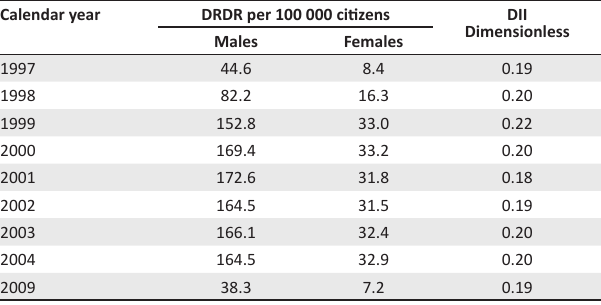
FIGURE 3: The unemployment inequality index (UEI) vs. the Human Development Index TABLE 6: Values of DRDRs and DII in South Africa between 1997 and 2004; and for 2009. Calendar year